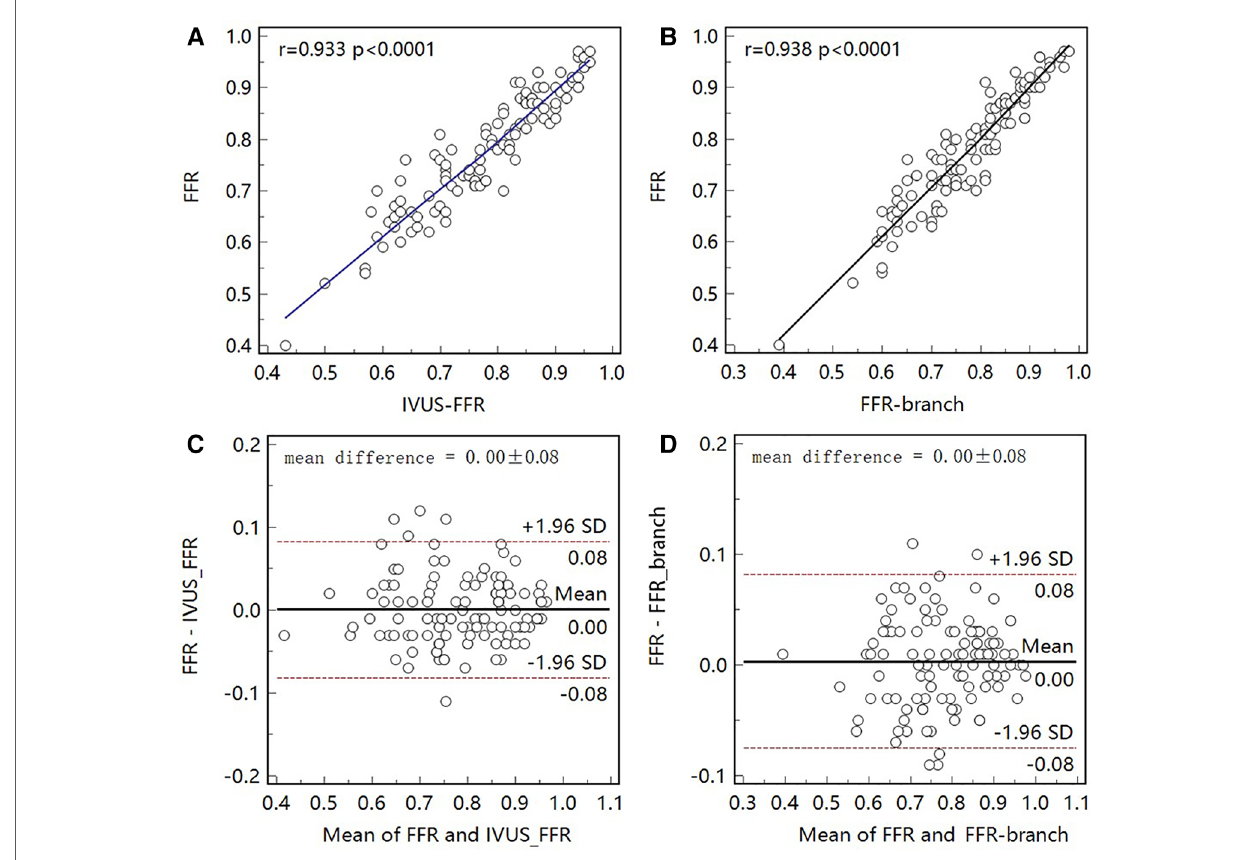
FIGURE 6 Correlation and agreement between invasive FFR and IVUS-FFR/FFR-branch. ( A , B ) Strong correlation ( r ¼ 0 : 933, 0.938) between invasive FFR and IVUS- FFR/FFR-branch was observed. ( C , D ) Bland-Altman plots show good agreement between invasive FFR and